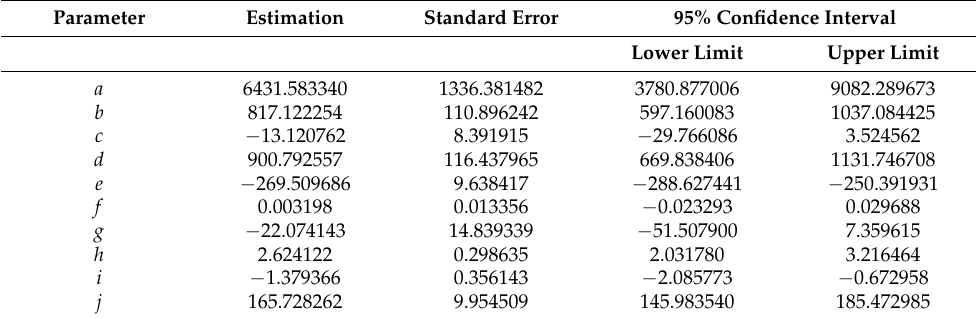
Table 7. Parameter